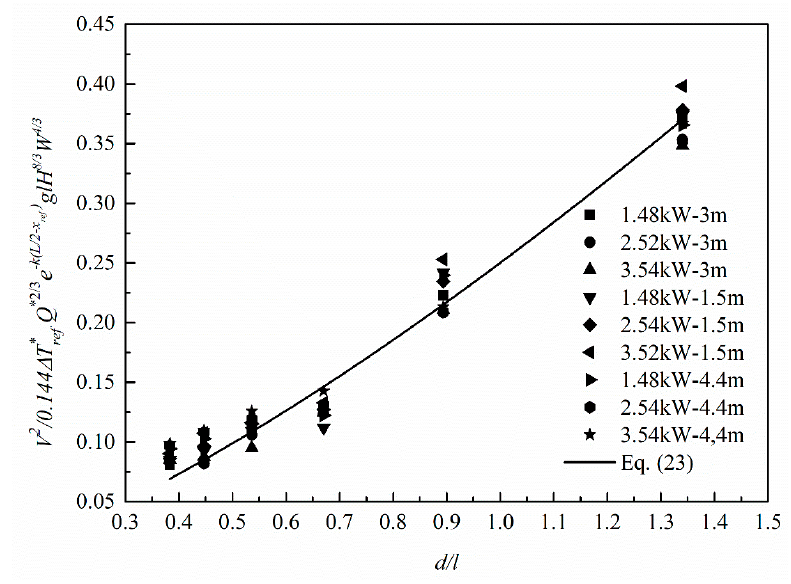
Figure 15. Experimental results fitted by Equation (23).